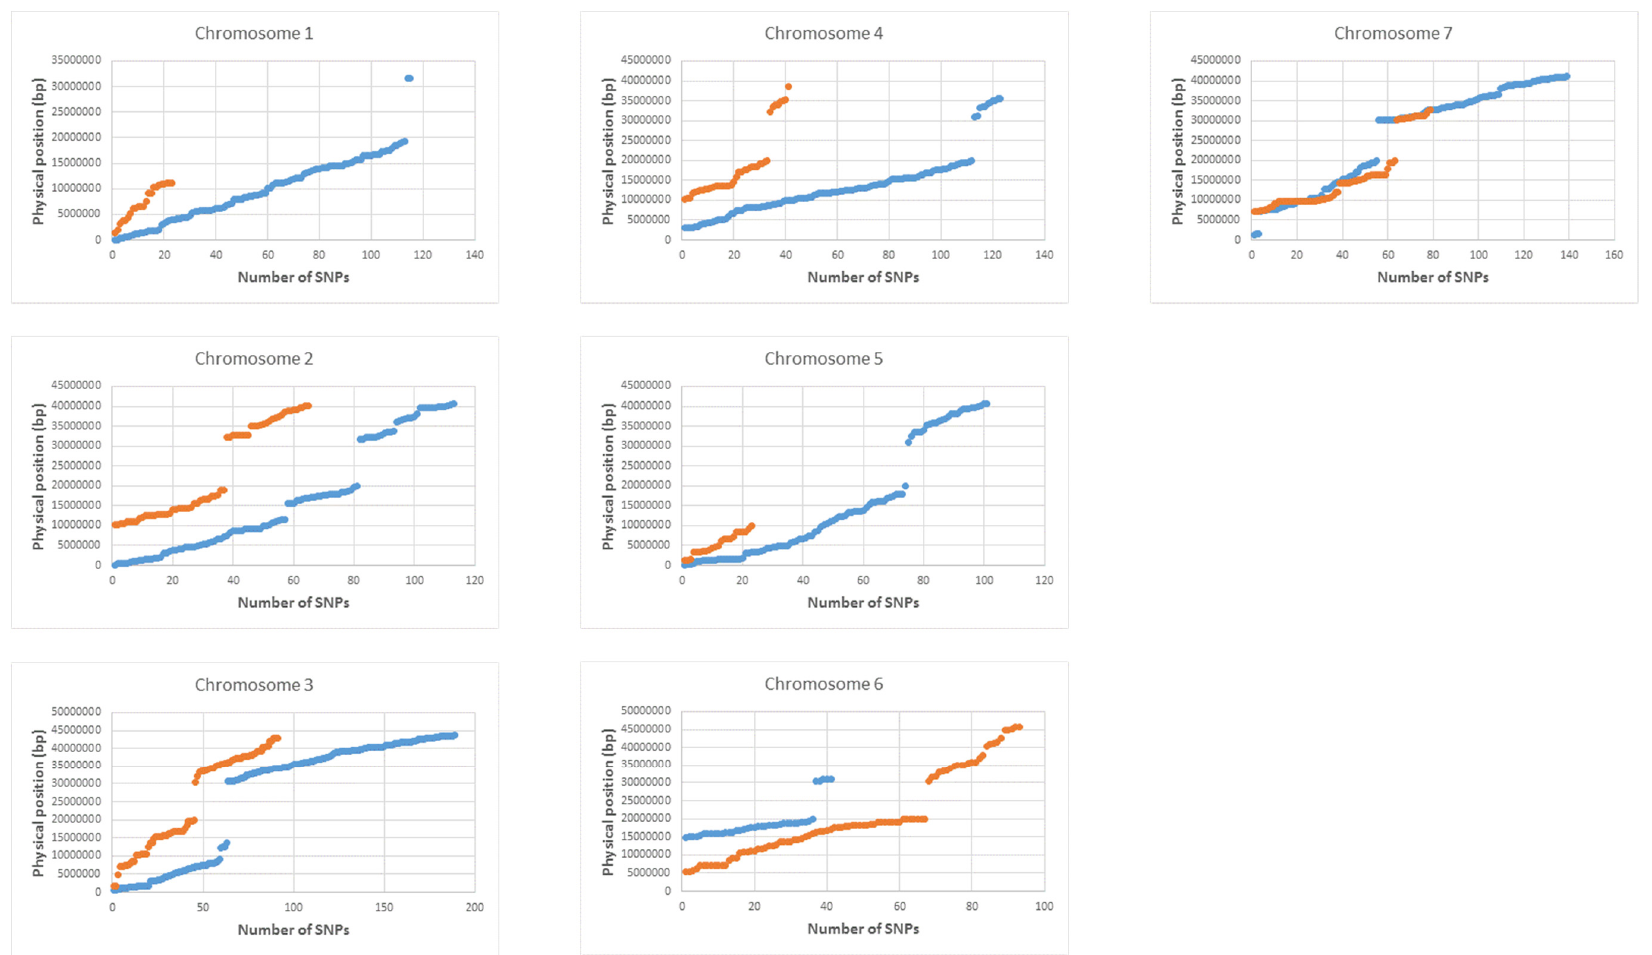
Figure 3. Comparisons of SNP markers in ‘Black Jewel’ (orange dots) and ‘Glen Ample’ (blue dots) maps, relative to their positions in the Rubus V3.0 chromosomes. Graph also shows regions (gaps) where SNPs were not identified / mapped for both species. A similar pattern of gaps is seen in both species.